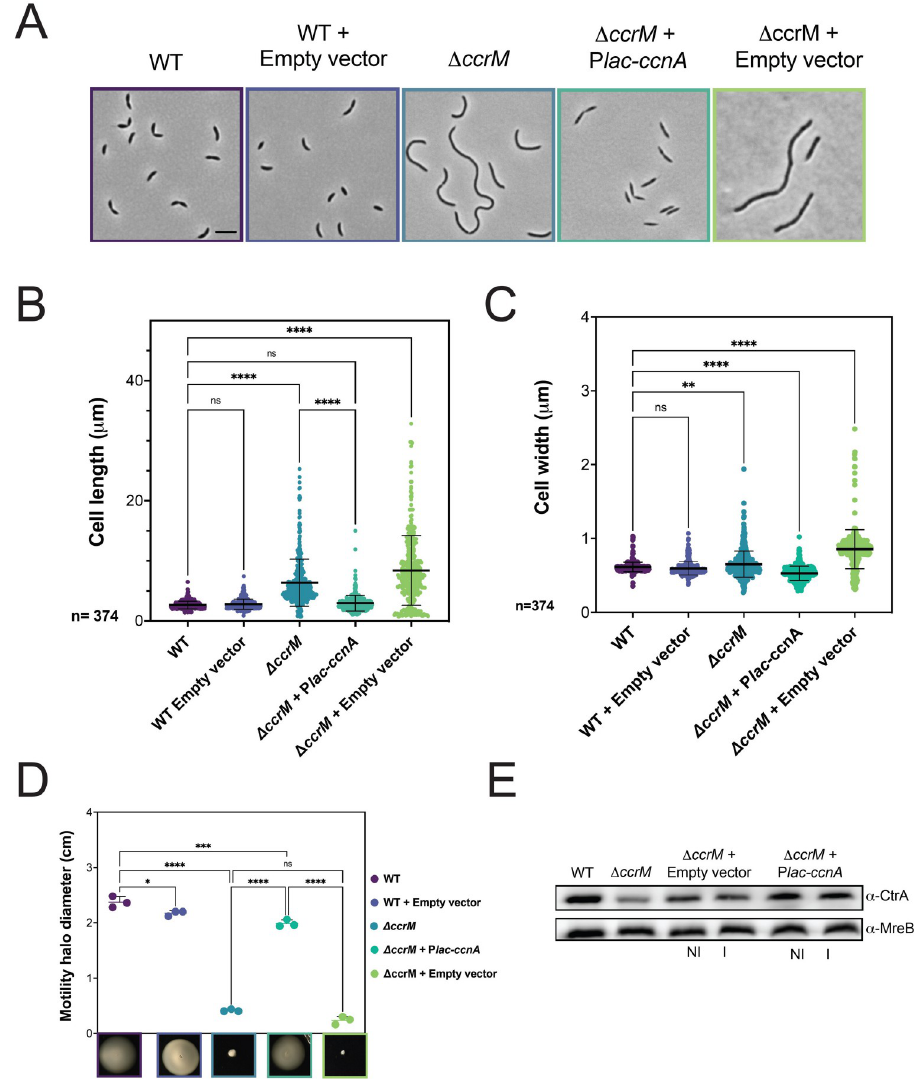
Fig 7. CcnA rescues the CcrM loss of function phenotype. (A) Phase contrast images of WT cells, WT cells carrying an empty pSRK (empty vector), Δ ccrM cells, Δ ccrM carrying a plasmid with ccnA under the control of a P lac promoter ( Δ ccrM+ P lac-ccnA ) o r Δ ccrM cells carrying an empty vector ( Δ ccrM+ empty vector) grown in PYE at 30˚C until OD 600nm = 0.6. Scale bar = 2 μ m. ( B, C) Cells from (7A) were analyzed using MicrobeJ [37], and 374 cells were analyzed to assess cell length and cell width. Statistical significance was determined using ANOVA with Sˇı´da´k’s multiple comparisons test. ns, difference not significant �� : p.val = 0.0050 ���� : p.val < 0.0001. Raw data are provided in S8 Table. ( D) Swarming assay on 0.25% soft agar plates. A volume of 1 μ L of each culture from cultures of Fig 7A was deposited into the soft agar and incubated at 30˚C for 5 to 6 d. N = 3. The diameter in cm of each mobility halo was measured with Fiji and reported in S4 Table. Statistical significance was determined using ANOVA with Sˇı´da´k’s multiple comparisons test. ns, difference not significant � : p.val = 0.0406, ��� : p.val = 0.0003, ���� : p.val < 0.0001. Data are in S9 Table. ( E) WT cells, Δ ccrM cells, Δ ccrM cells carrying an empty vector or P lac-ccnA were grown in PYE at 30˚C until OD 600nm = 0.6. Then, induction of P lac-ccnA was made by addition of IPTG 1 mM 30 min. As a control of induction, Δ ccrM cells carrying an empty vector were also incubated 30 min in the presence of IPTG 1 mM. Proteins were extracted and separated on a SDS-PAGE gel for Western blotting. CtrA and MreB (loading control) proteins were revealed using specific polyclonal antibodies on nitrocellulose membranes. In comparison with the control strain (empty vector), cells over expressing CcnA show + 35% and + 30% of CtrA in NI and I conditions, respectively. CcnA, cell cycle noncoding RNA A; WT, wild-type.